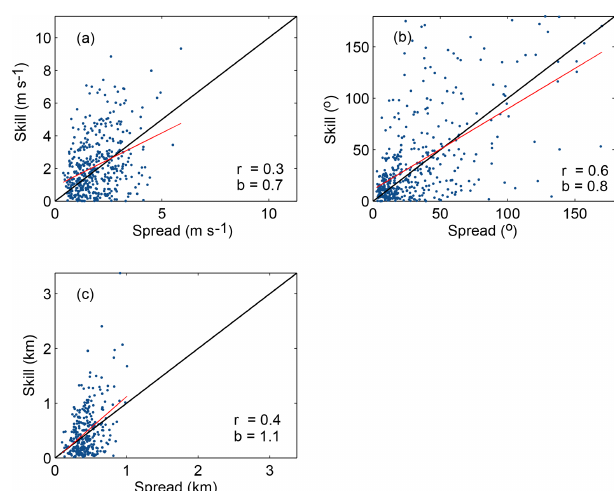
Figure 7. Spread–skill relationship for (a) wind speed, (b) wind di- rection and (c) PBLH using the 14 rawinsonde sites available over the region. Each point represents the model ensemble spread (stan- dard deviation of the model–data difference) and skill (mean abso- lute error) for each observation. A one-to-one line is plotted in black and a line of best fit is plotted in red. Correlation ( r ) and slope (b) of the line of best fit of the spread–skill relationship are plotted as